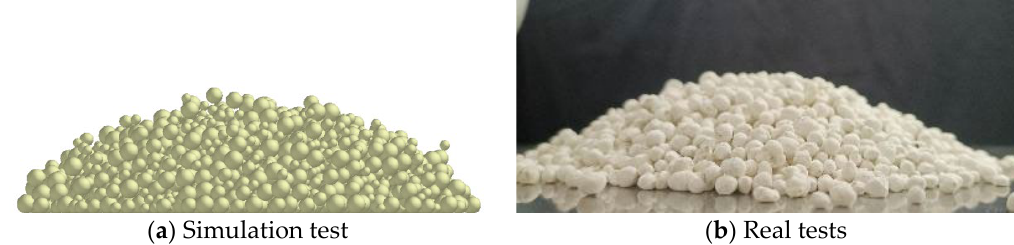
Figure 9. Comparison between simulation test and real test ( a , b